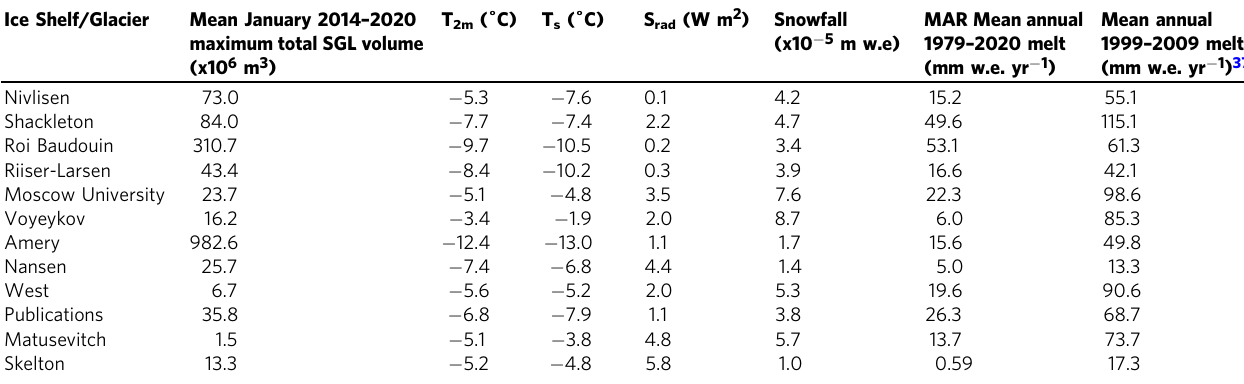
Table 1 Mean 2014 – 2020 values of climatic variables extracted from ice shelf/outlet glacier grounding zones (Methods, Supplementary Fig.